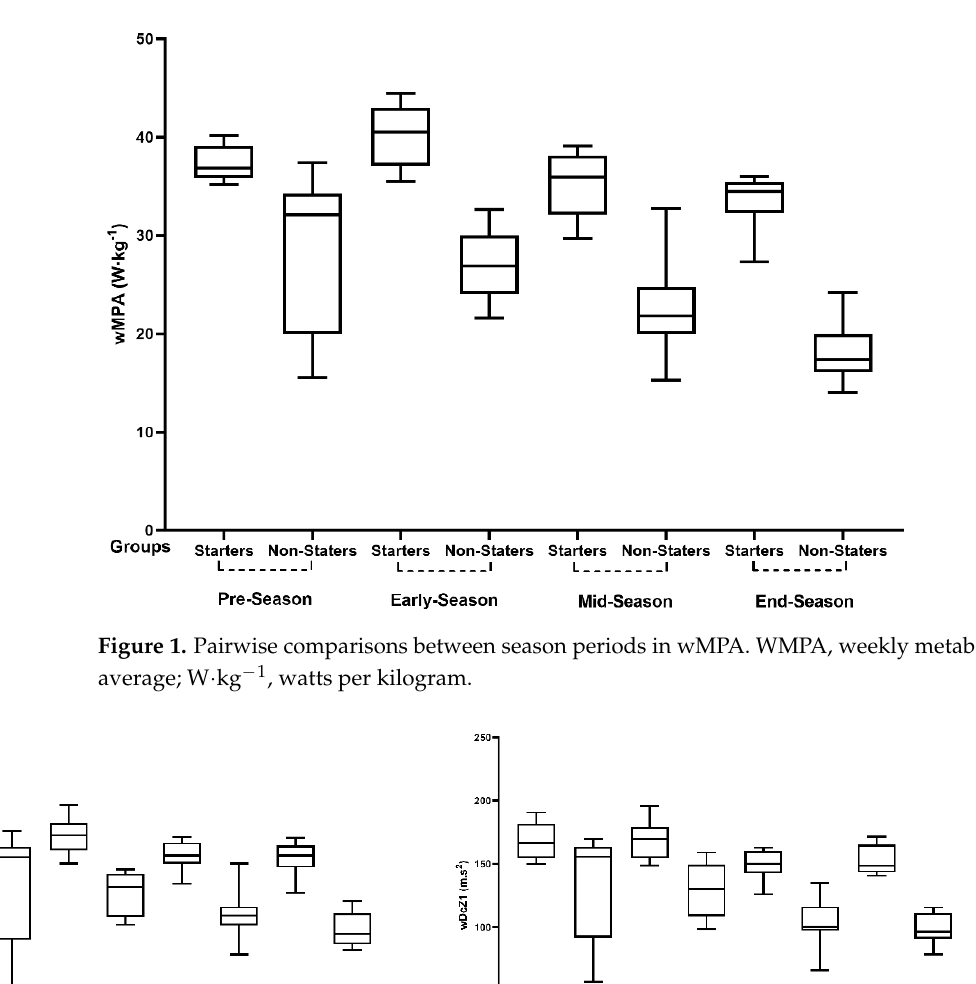
6 of 14 Table 2. Within-group differences for pairwise comparisons between season periods in wMPA for starter and non-starter players. Variable